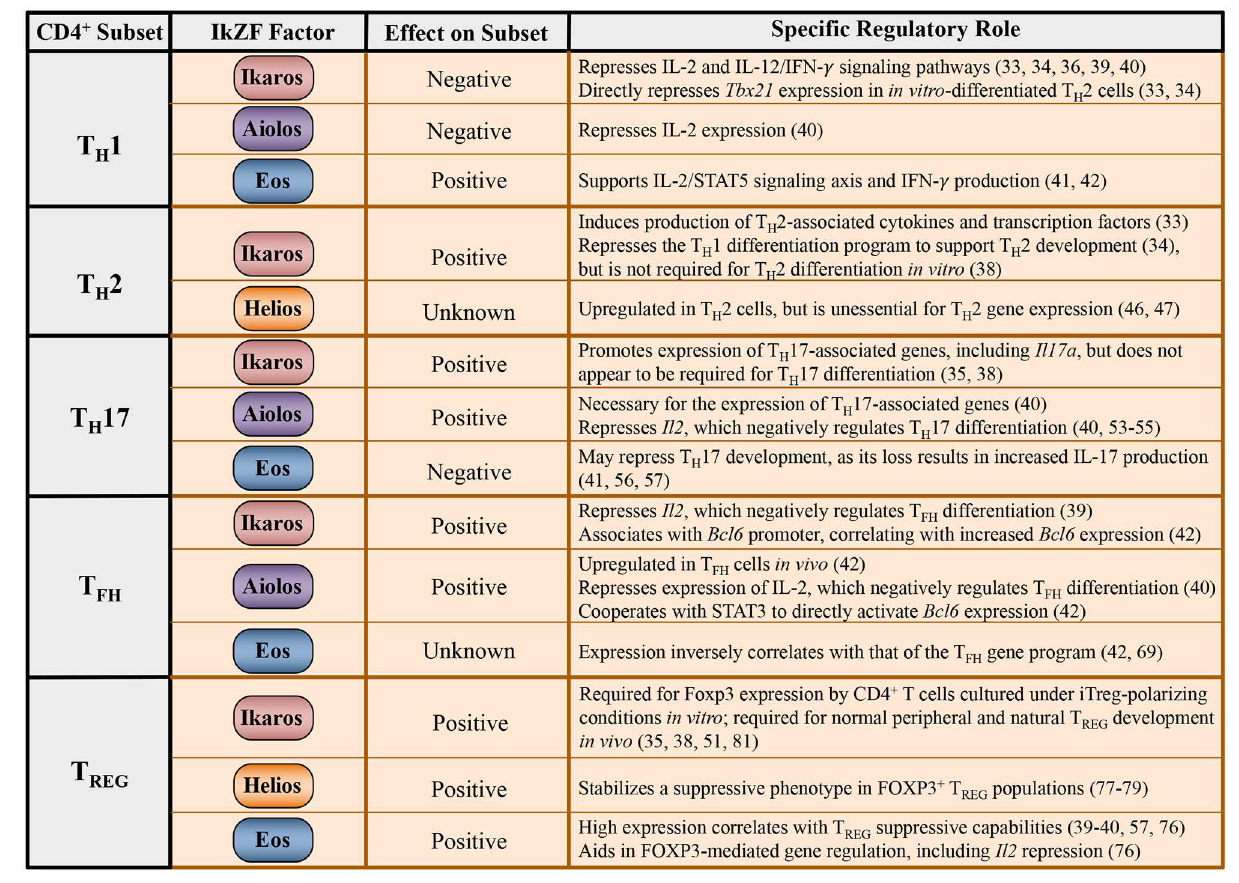
FIGURE 2 | Regulation of CD4 + T cell differentiation programs by IkZF family members. Tabulated summary of the known effects of IkZF family members on expression of the T H 1, T H 2, T H 17, T FH , and T REG gene programs, including associated cytokines and transcription factors. The broad impact of each IkZF factor on the differentiation program of individual T helper cell subsets is also provided, if